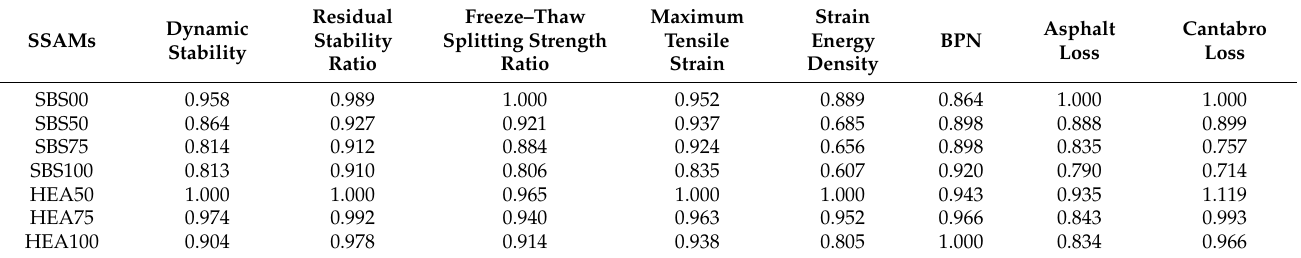
Table 9. Normalized data.